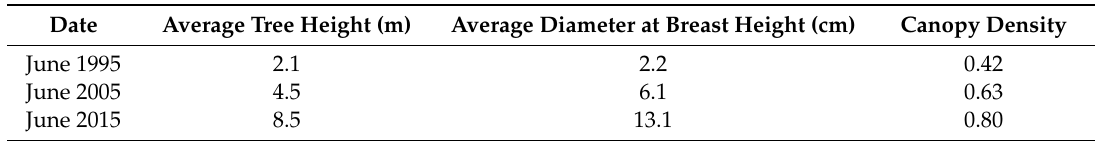
Table 1. Basic information of the sample